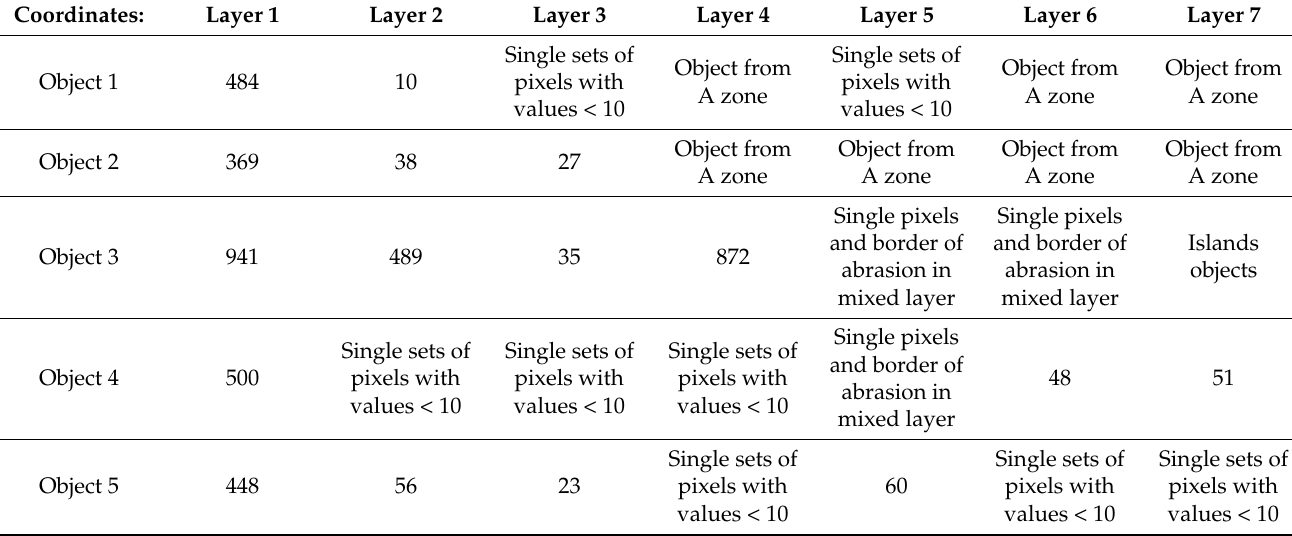
Table 2. Forming of the area of given objects on each of